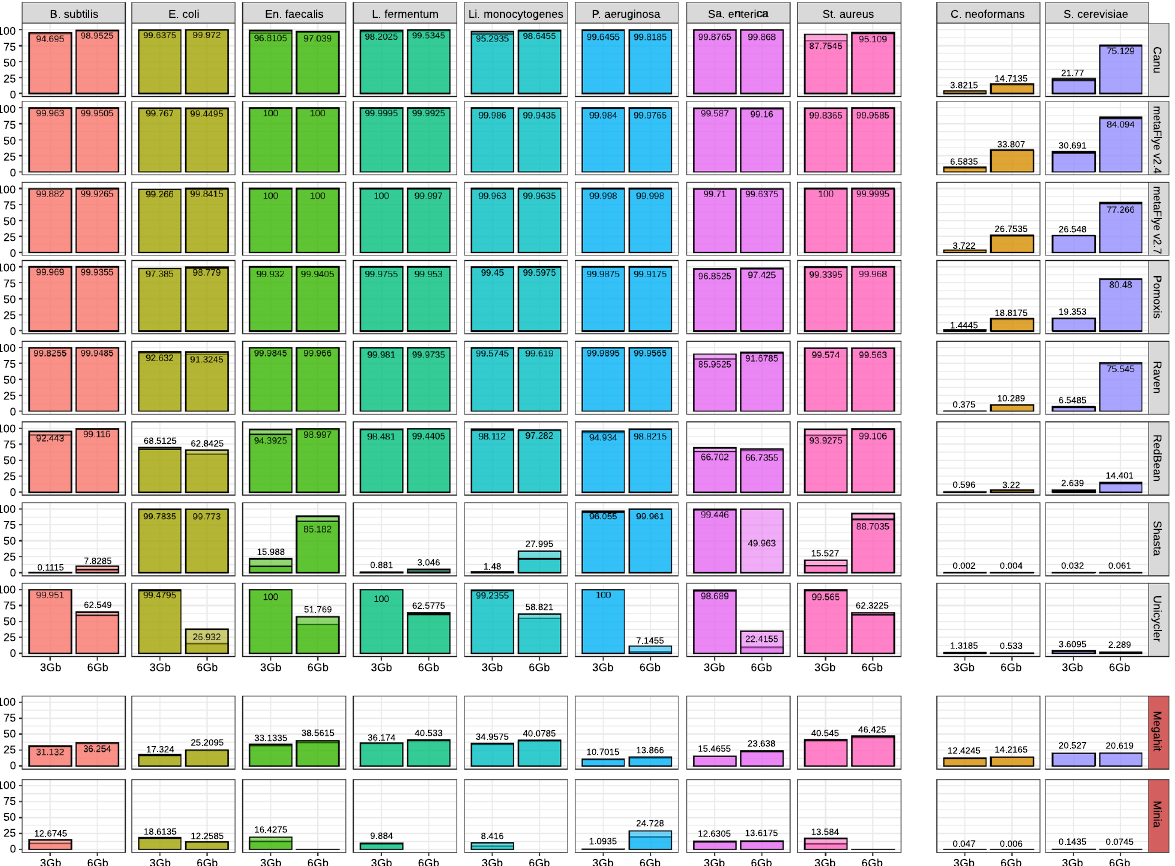
Figure 2. Fraction of the genome covered by the draft assemblies obtained using each tool, and for each individual microorganism (subsampled Even datasets). Miniasm assemblies are not shown, since it was not possible to evaluate them with